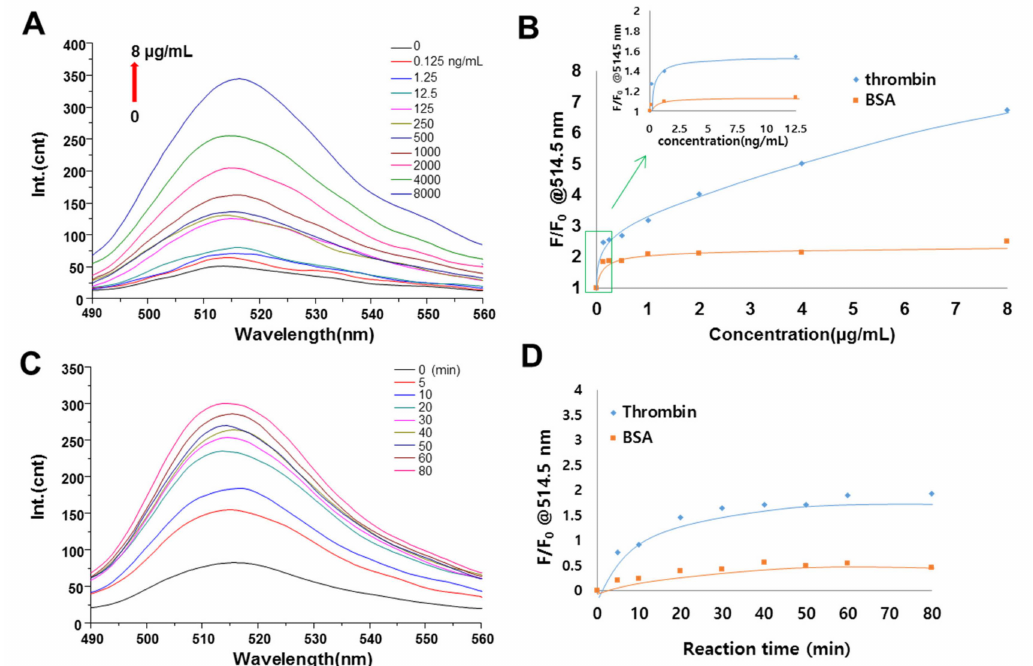
Figure 6. Fluorescence signals from FITC-LVPRGS-PEG 800 -MGO biosensors upon peptide cleavage by thrombin. ( A ) Fluorescence emission spectra of FITC-LVPRGS-PEG 800 -MGO FRET biosensors in the presence of thrombin at concentration of 0 to 8 µ g / mL for 30 min. ( B ) Fluorescence intensity recovery (F / F 0 ) at 514.5 nm from FITC-LVPRGS-PEG 800 -MGO in response to di ff erent concentrations of thrombin when compared with BSA. ( C ) Temporal fluorescence emission spectra of FITC-LVPRGS-PEG 800 -MGO FRET biosensors from 0 to 100 min at 2 µ g / mL of thrombin. ( D ) Time-dependent fluorescence intensity recovery (F / F 0 ) at 514.5 nm in FITC-LVPRGS-PEG 800 -MGO at 2 µ g / mL of thrombin when compared to BSA (2 µ g /